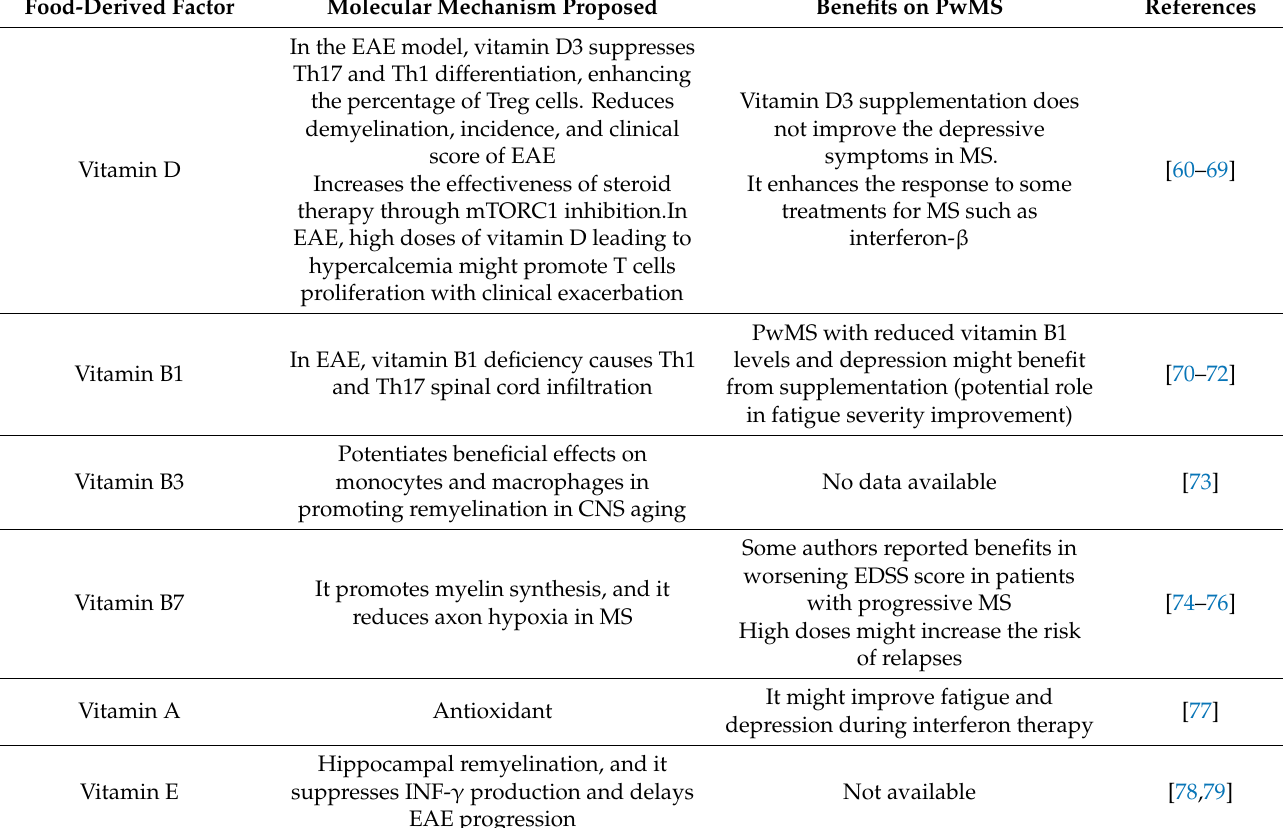
Table 4. Molecular mechanism and possible advantages on pwMS of food-derived vitamins. Food-Derived Factor Molecular Mechanism Proposed Benefits on